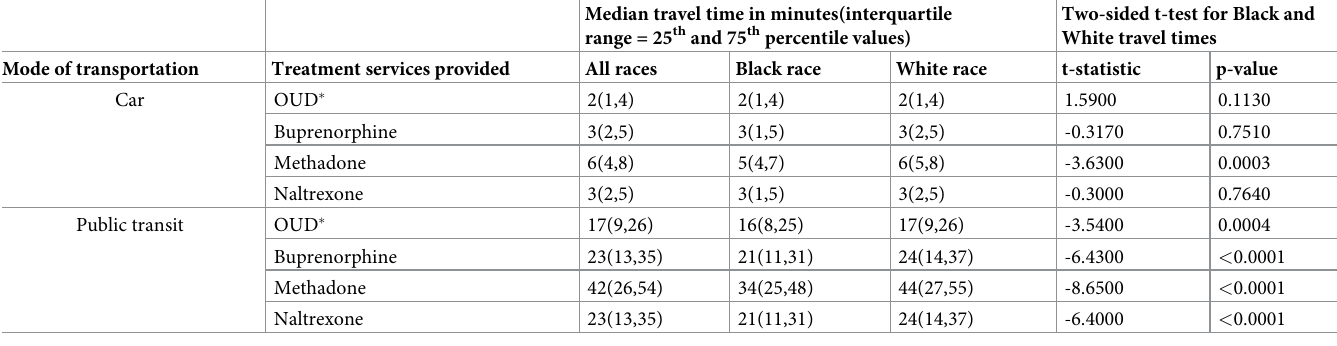
Table 2. Travel time (in minutes) to facility by type of services offered and by mode of transportation.